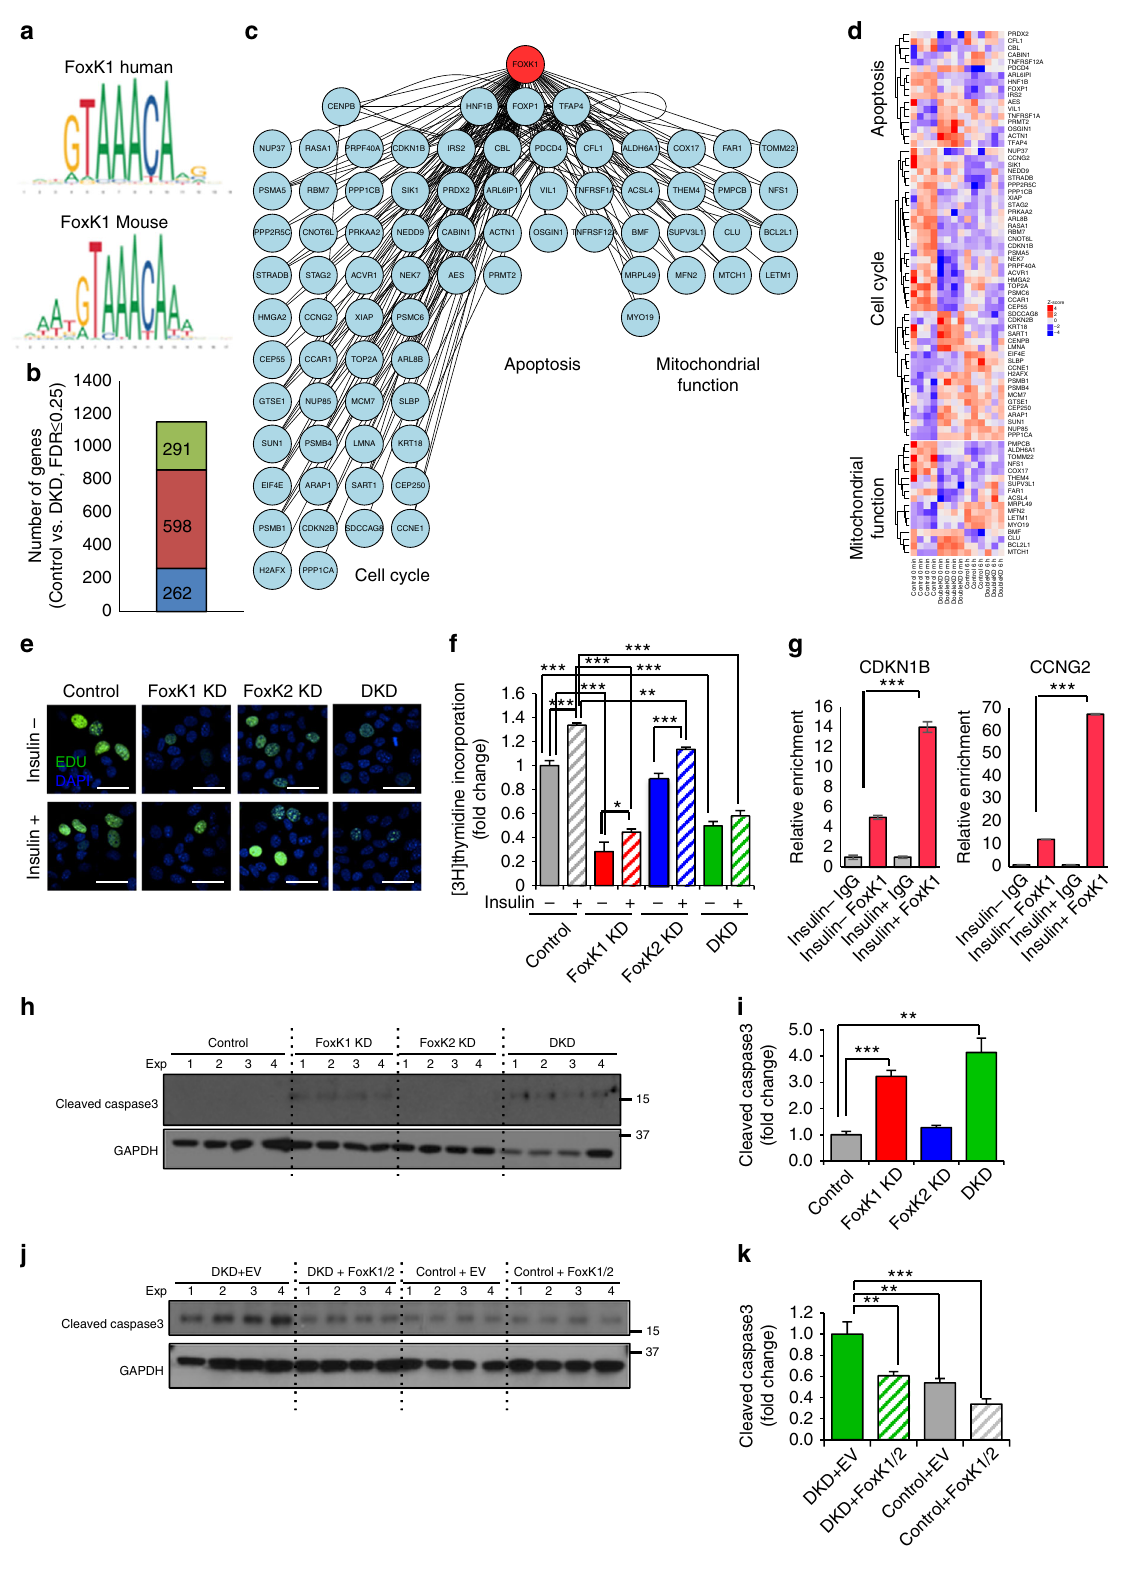
Cell proliferation assay using [ 3 H]-thymidine incorporation . Cells were plated 5 ×10 4 per well to 24-well plates. On the next day cells were starved with serum- free DMEM/F12 containing 0.1% BSA media for 24 h then labeled with 0.2 μ Ci [ 3 H]-thymidine per well for 24 h in the presence or absence of 100 μ M insulin. After labeling, the cells were washed twice with PBS and precipitated with 500 μ l